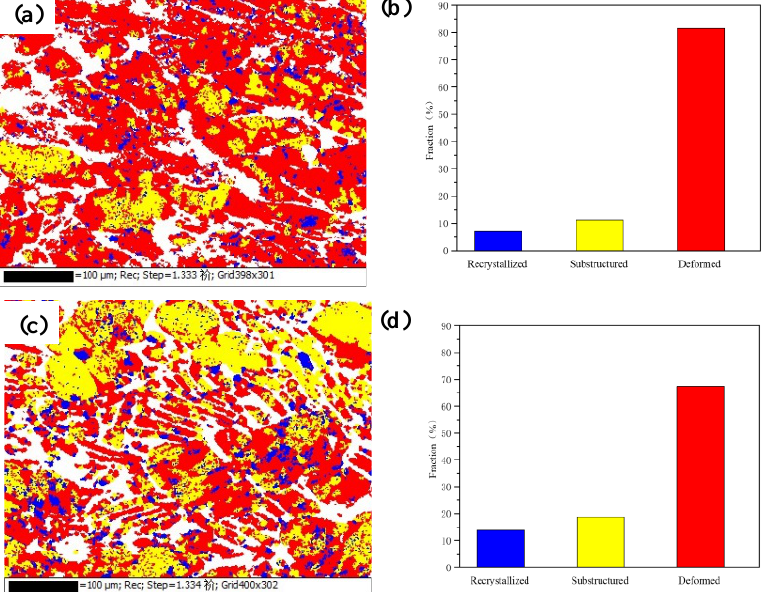
Figure 13. The α -Mg phase’s recrystallized fraction maps and corresponding fraction of three types microstructure when the strain rate is 0.01 s − 1 . ( a , b ) T = 473 K and ( c , d ) T = 573 K.